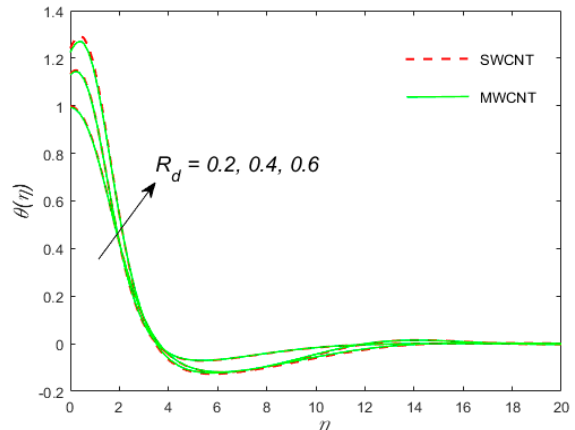
Figure 8. The impact of the temperature distribution profile θ ( η ) for the case of SWCNT and MWCNT versus the similarity variable for the distinct values of the Boit number ( B 1 ).